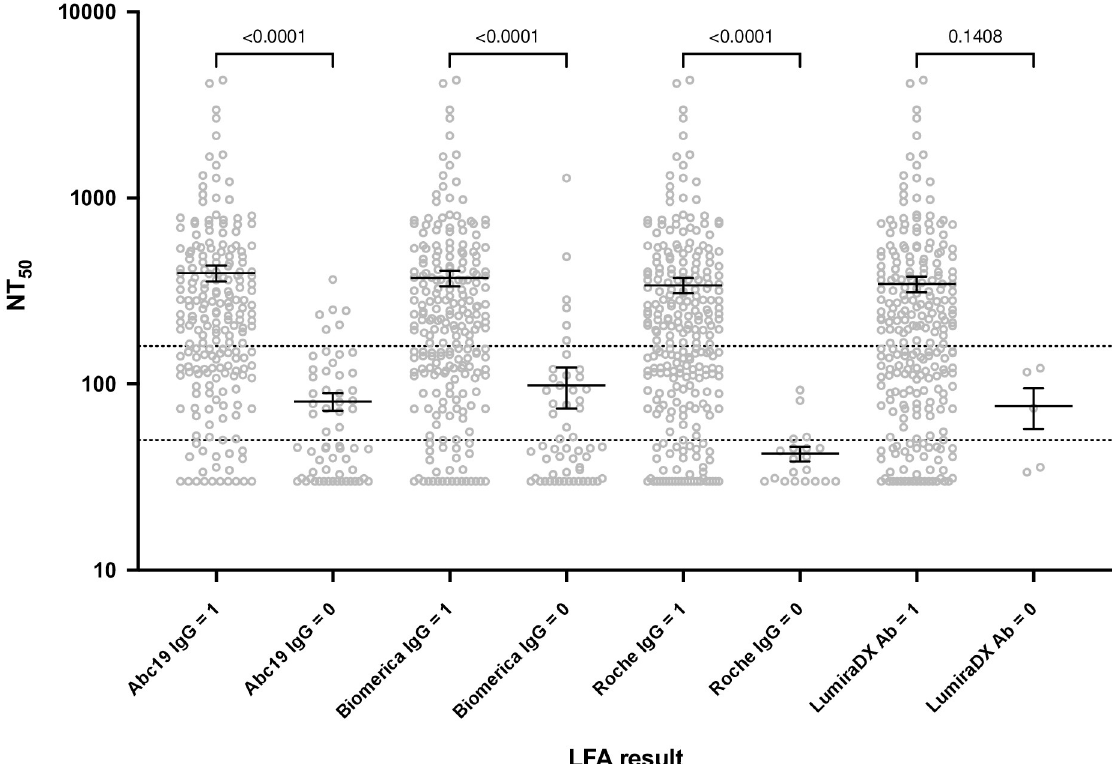
Fig 4. Neutralising antibody titres compared to POC test result. NT 50 against binary POC test result. The NT 50 results for the positive and negative device result are plotted by kit (the mean and standard error of the mean (SEM) are denoted by black lines). Dotted lines represent the NT 50 � 50 and � 160 thresholds, and the p values from a Kruskal-Wallis test are shown.